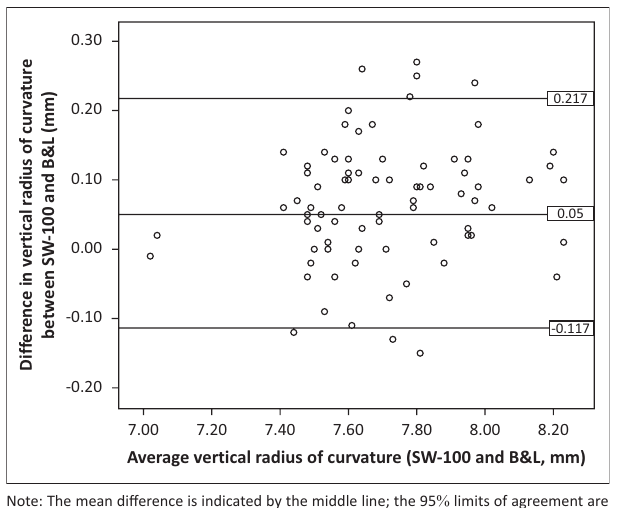
Note: The mean difference is indicated by the middle line; the 95 % limits of agreement are the lines on both sides of the midline. FIGURE 2: Differences in vertical radius of curvature between the SW-100 and Bausch & Lomb keratometers, plotted against the mean vertical radii of curvature.